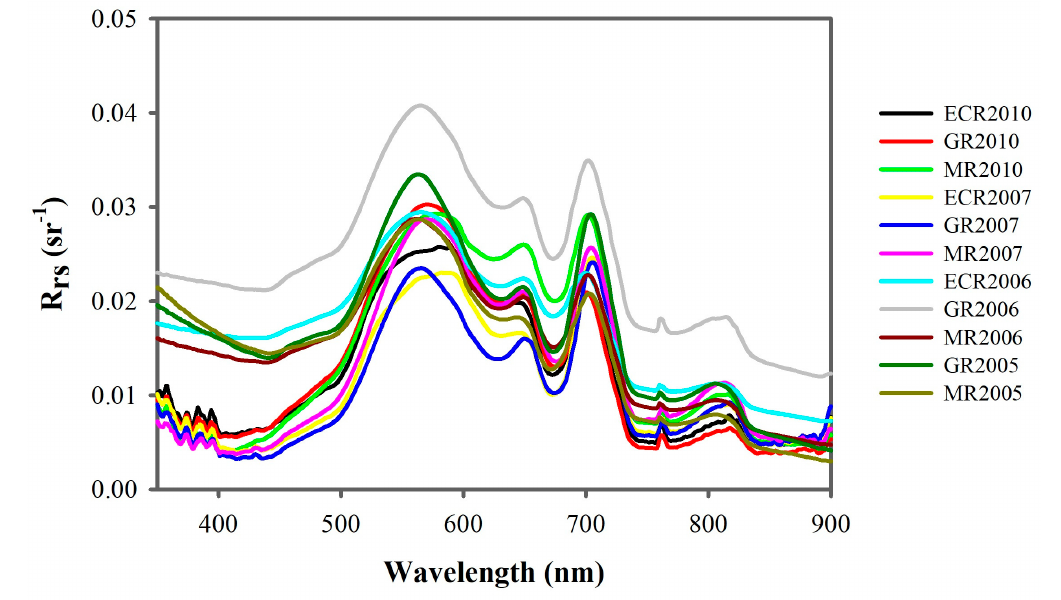
Figure 3. Average R rs (sr − 1 ) spectra for each dataset. Table 3. Coefficients of Determination for semi-empirical PC estimation algorithms calibrated on the 2005–2007 datasets. Best performances are highlighted in bold.